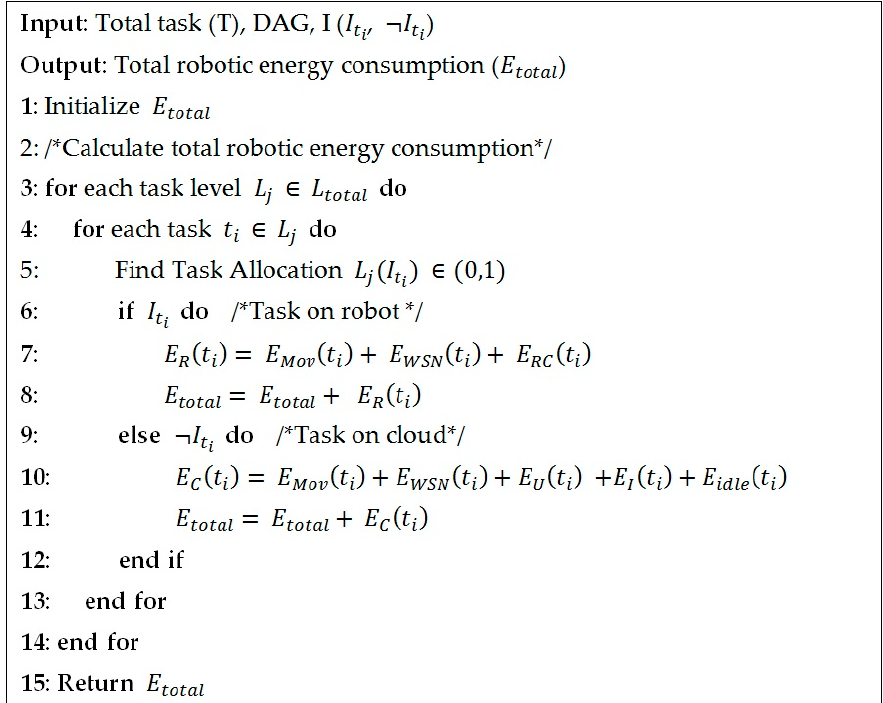
Figure 4. Pseudo-code for calculating the total robotic energy. J. Sens. Actuator Netw. 2016 , 5 , 20